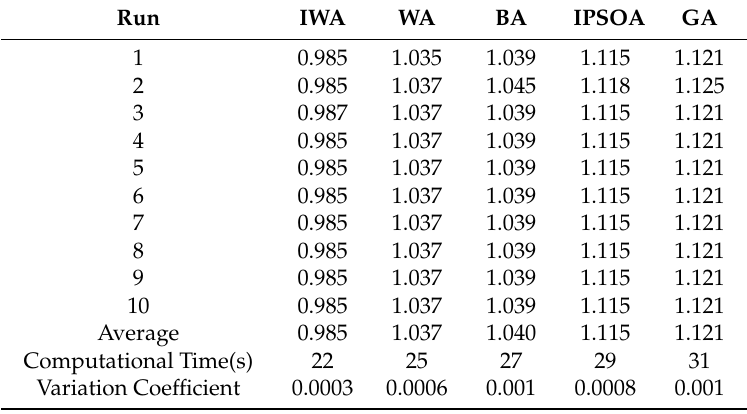
Table 6. Ten random results for high inflow.